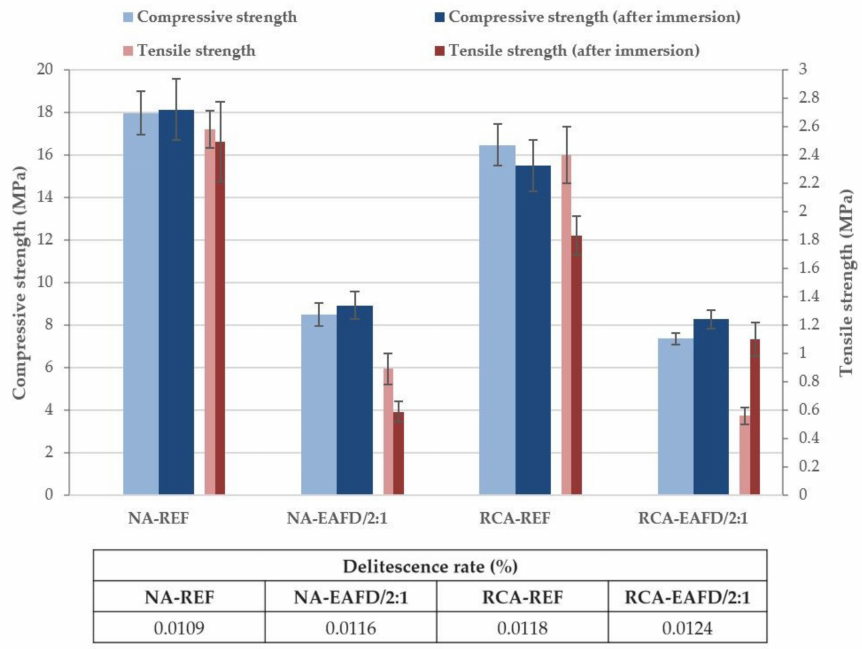
Figure 2. Results (mean values and standard deviation) of the mechanical properties.